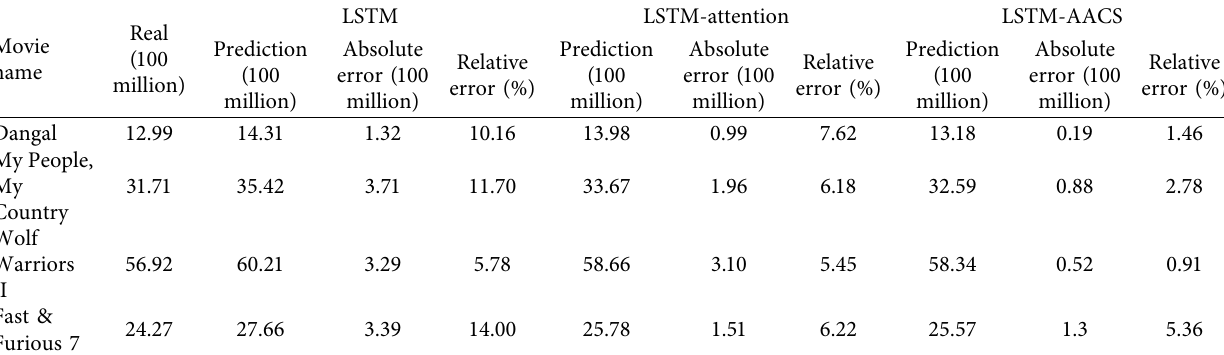
Table 2: Movie box office prediction results of previous classic